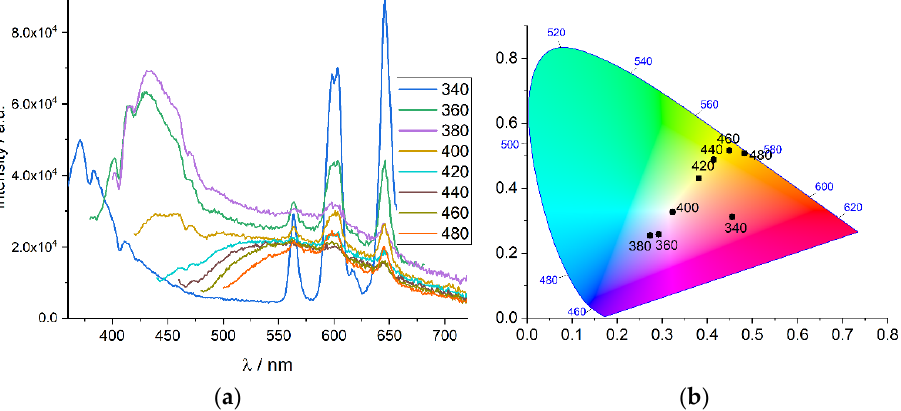
Figure 7. Emission spectra for 2 Sm at different excitation wavelengths ( a ). CIE 1931 chromaticity diagram for 2 Sm calculated from emission spectra ( b ).